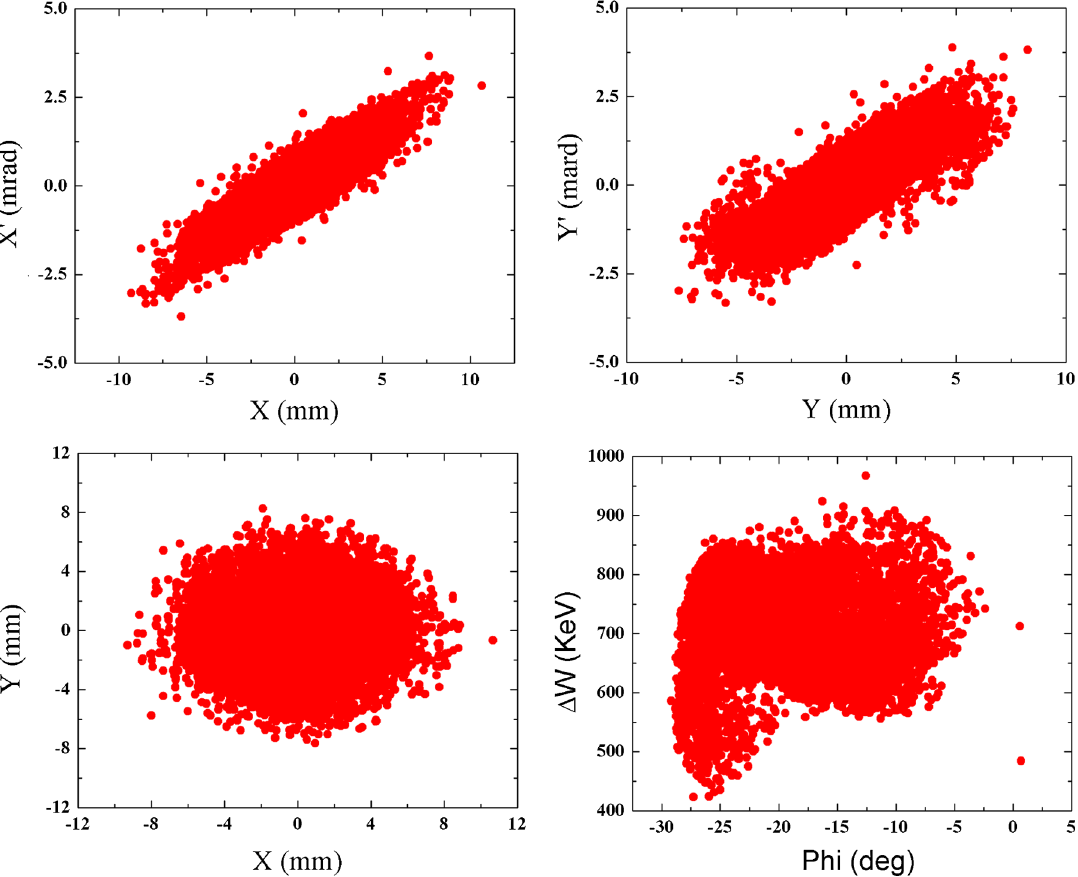
FIG. 36. The output particle distribution at the exit of the DTL section.